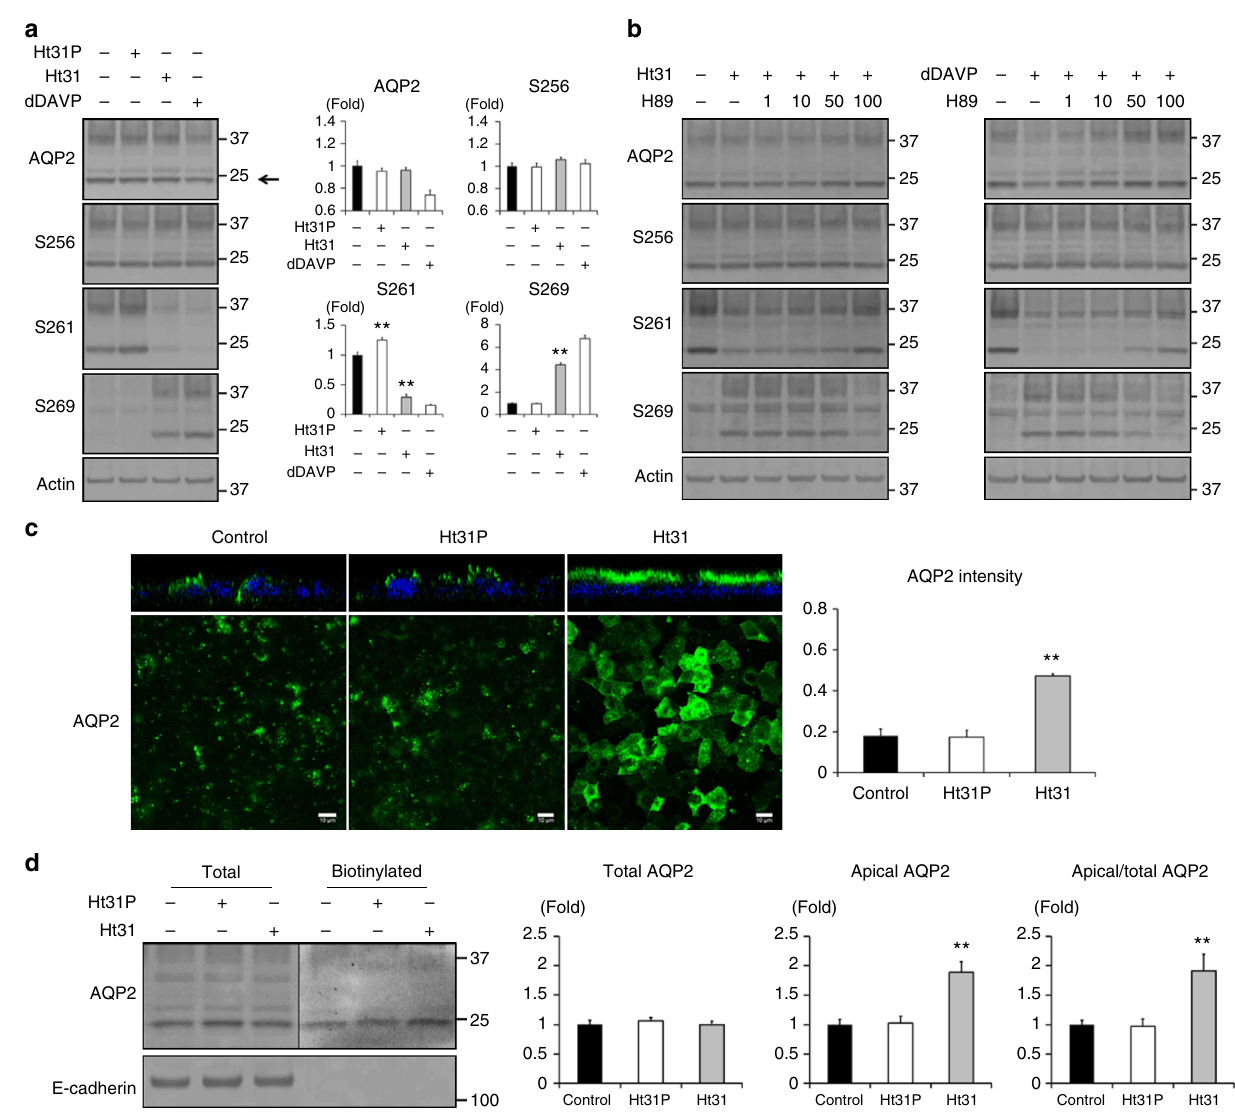
Fig. 2 Ht31 regulates AQP2 phosphorylation and traf fi cking. a Western blot analysis of total and phosphorylated AQP2. (Left) Ht31P (50 µ M), Ht31 (50 µ M), or dDAVP (1 nM) was added to the basolateral side of the mpkCCD cells for 1 h. (Right) Non-glycosylated AQP2 bands (arrow) were quanti fi ed by densitometric analysis, and the results are presented in the bar graphs as the fold change, as compared to the values of the control cells. Bars are mean values ± SD of three experiments. Asterisk indicates a signi fi cant difference, as compared with the control. Tukey, ** p < 0.01. b Dose-response studies of H89. Ht31 (50 µ M) or dDAVP (1 nM) was added in the presence or absence of H89 (1 – 100 µ M) for 1 h. The mpkCCD cells were pretreated with H89 for 1 h before Ht31 or dDAVP stimulation. Representative blots of three independent experiments are shown. c The subcellular localization of AQP2. (Left) The mpkCCD cells were treated with Ht31P (50 µ M) or Ht31 (50 µ M) for 1 h, and the subcellular localization of AQP2 was then analyzed by immuno fl uorescence using confocal microscopy. The larger panels display confocal sections of the apical regions of the cells. Z-stack confocal images are shown at the top of each panel. Representative confocal images of three independent experiments are shown. Scale bars, 10 µ m. (Right) Fluorescence intensities of apical AQP2 were quanti fi ed and the results are presented in the bar graphs. Bars are mean values ± SD of three experiments. Asterisk indicates a signi fi cant difference compared with control. Tukey, ** p < 0.01. d Biotinylation analysis of Ht31-induced apical AQP2 expression. (Left) The mpkCCD cells were treated with Ht31P (50 µ M) or Ht31 (50 µ M) for 1 h. The amount of AQP2 in the apical plasma membrane was quantitated by apical surface biotinylation. (Right) Non-glycosylated total and apical (biotinylated) AQP2 bands were quanti fi ed by densitometric analysis, and the results are presented in the bar graphs as the fold change, as compared to the values of the control cells. Bars are mean values ± SD of three experiments. Asterisk indicates a signi fi cant difference, as compared with the control. Tukey, ** p < FMP-API-1 increases AQP2 activity in vitro . As Ht31-induced Supplementary Fig. 5a). Immuno fl uorescent analysis showed that AQP2 traf fi cking (Fig. 2c, d), PKA activation by FMP-API-1 also FMP-API-1 signi fi cantly increased apical AQP2 expression increased AQP2 activity in mpkCCD cells. FMP-API-1 sig- (Fig. 4c). Remarkably, the ef fi cacy of FMP-API-1 in AQP2 traf- fi cking was almost equal to that of dDAVP. Also, apical surface ni fi cantly phosphorylated AQP2 at S269 and signi fi cantly dephosphorylated AQP2 at S261, while AQP2 phosphorylation at biotinylation analysis showed that FMP-API-1 increased apical S256 was constitutively high (Fig. 4a). These changes in AQP2 AQP2 expression to the same extent as dDAVP (Fig. 4d, Sup- phosphorylation status were inhibited by H89 (Fig. 4b, plementary Fig. 5b). Functional analysis of osmotic water